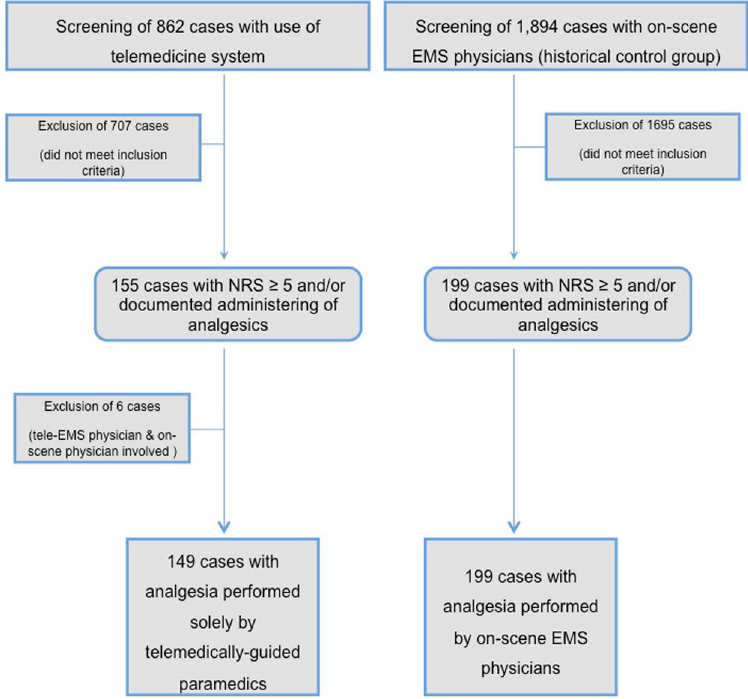
Figure 2. Study flow